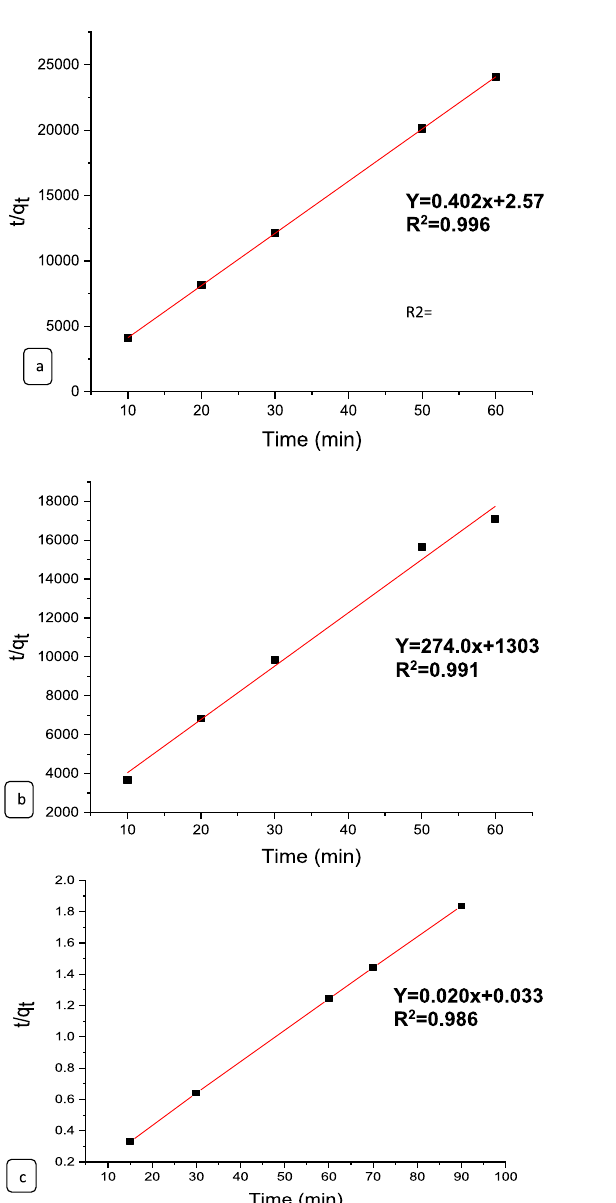
Fig. 16 Thermodynamic for the adsorption of MG onto a nano-bentonite, b MgO impregnated clay and c raw